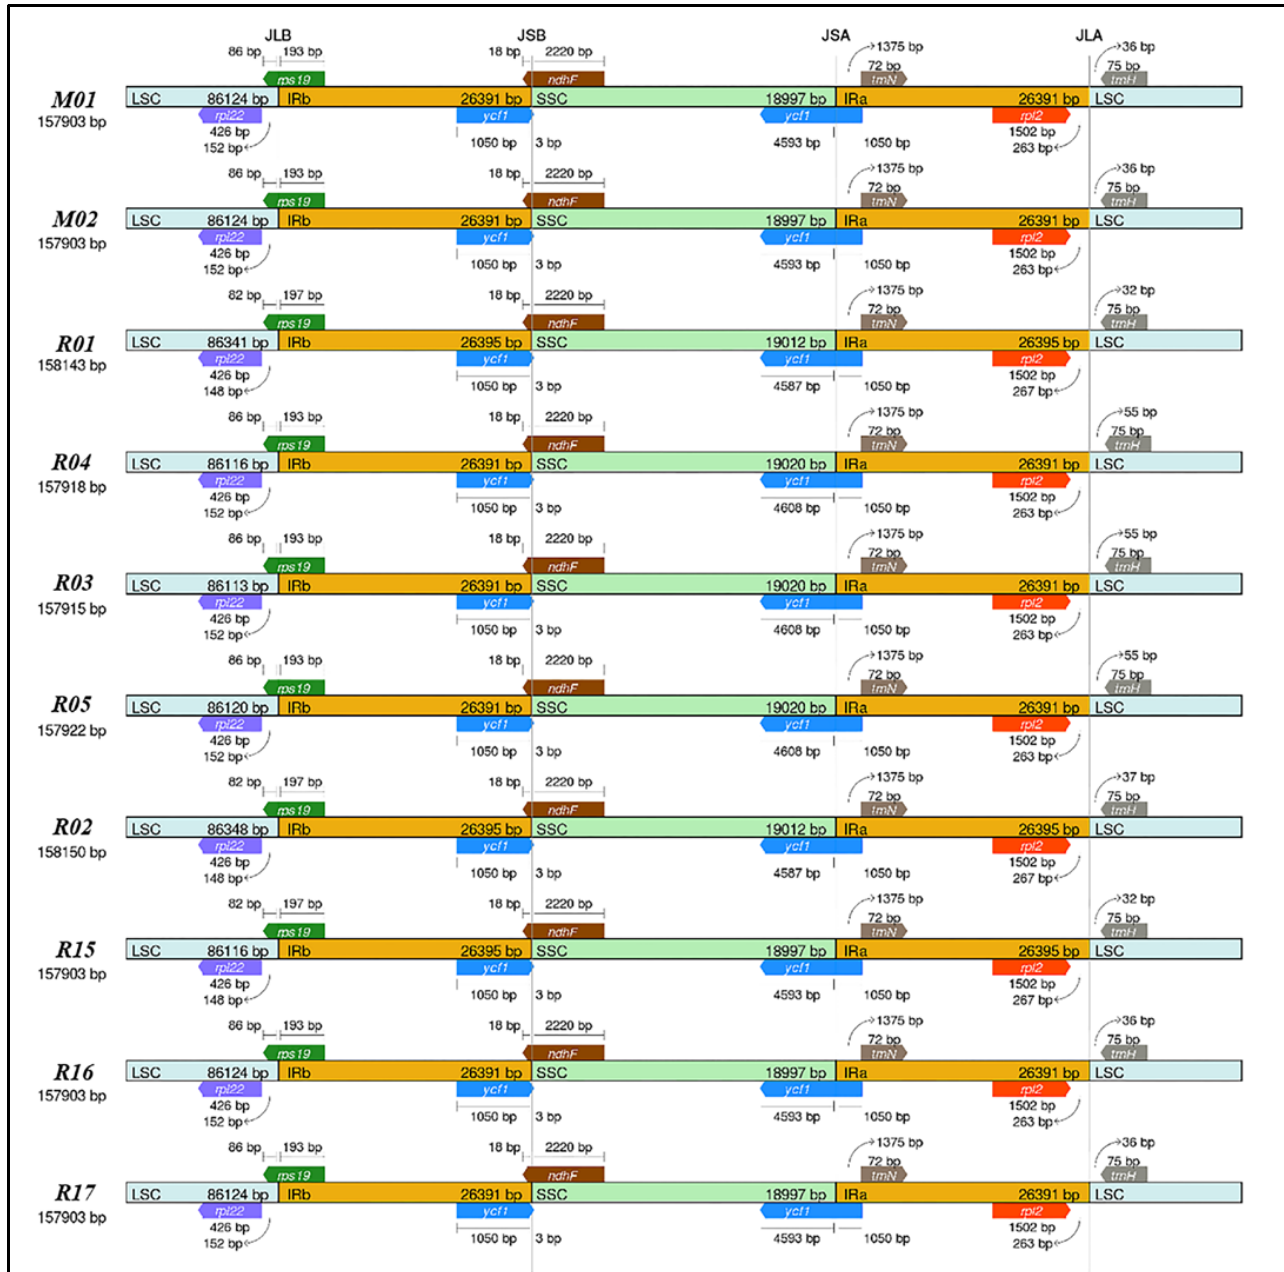
Figure 6. Analysis of changes in the boundaries of small single-copy, large single-copy and inverted repeat regions in the chloroplast genome among the ten Prunus mume accessions: R05, M02, R01, R03, R16, R15, R1, R02, M01 and R04.